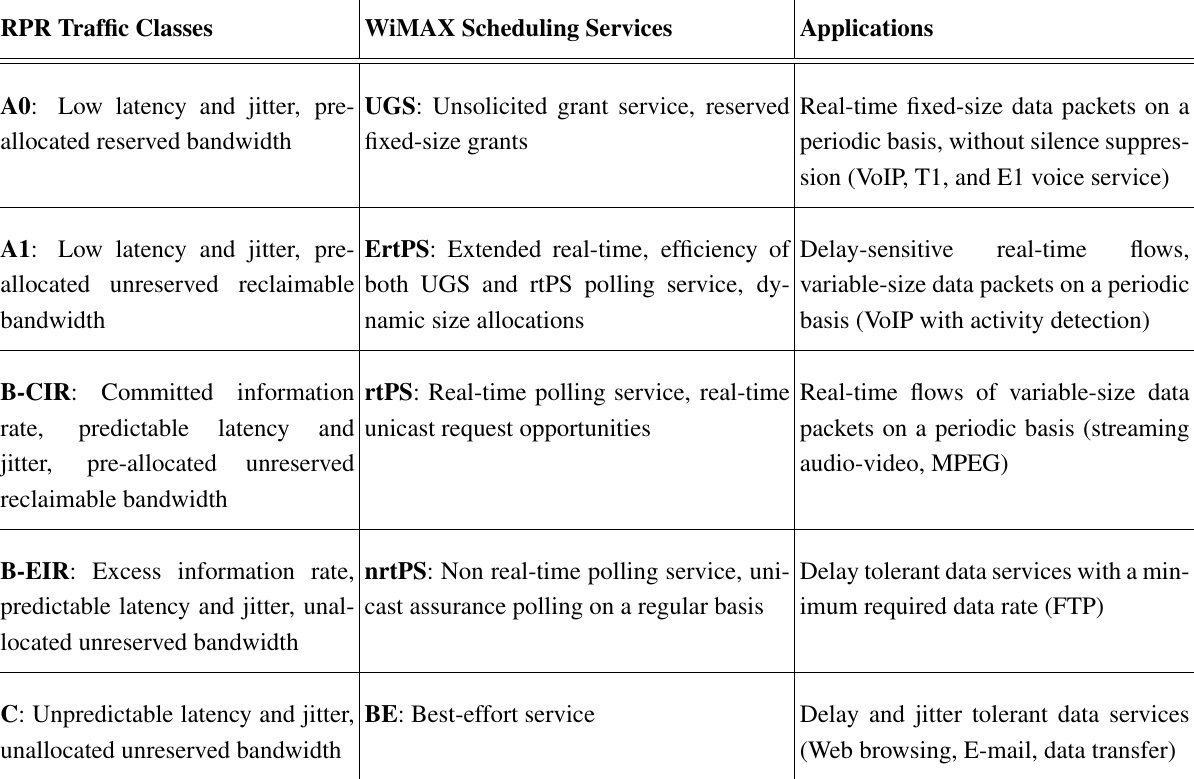
Table 1. Bidirectional mapping of RPR traffic classes and WiMAX scheduling